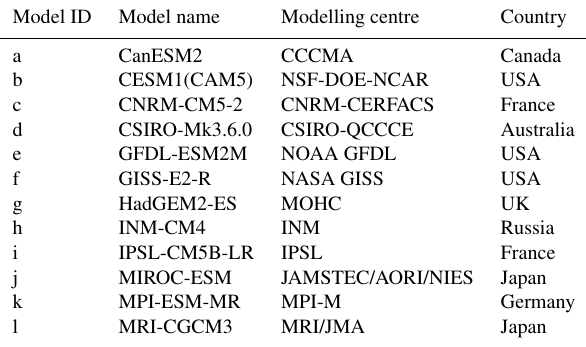
Table 1. Climate models used in the study. For more details of the models, see Table 9.1. in IPCC